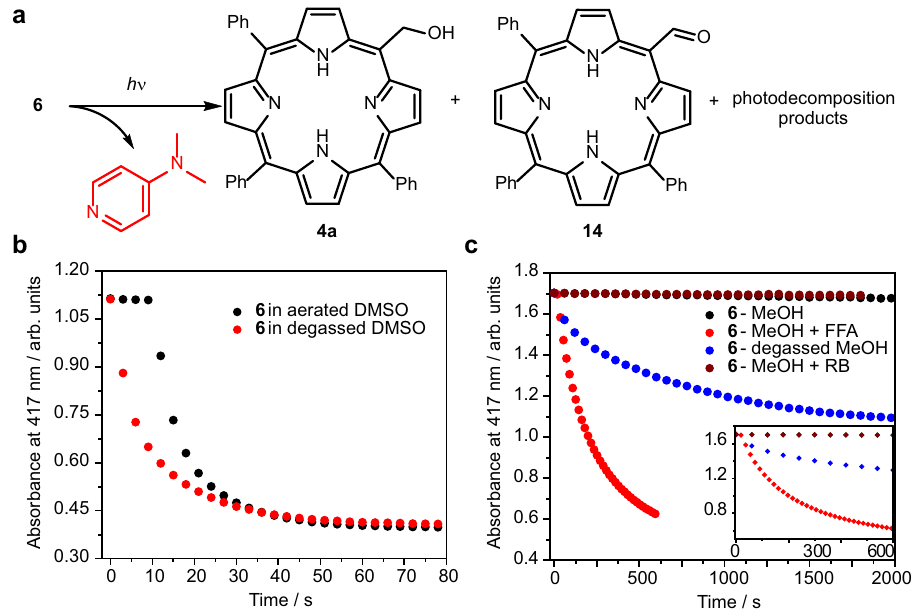
Fig. 5 Photoreaction kinetics of DMAP-caged porphyrin derivatives. a Photoproducts formed upon photoexcitation ( λ irr = 410 nm, 18 mW cm − 2 ) of 6 (25 µ M) in a degassed DMSO solution. b Photochemistry of 6 (3 µ M) in aerated or degassed DMSO solutions. c Photochemistry of 6 (3 µ M) in aerated or degassed methanol solutions ( λ irr = 420 nm) and in the presence of a singlet oxygen generator (rose bengal, RB, λ irr = 545 nm, 52 mW cm − 2 ) or quencher (furfuryl alcohol, FFA). Inlet: focus on early time